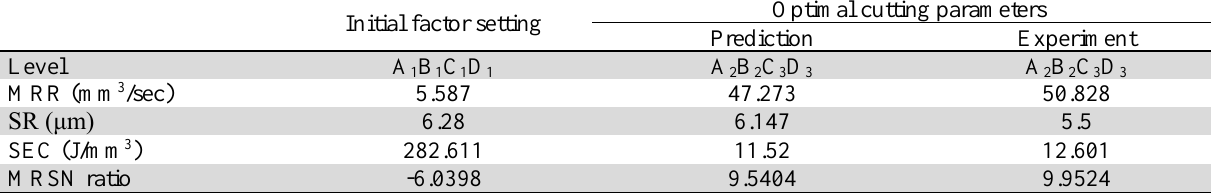
Results of the confirmatory experiment for MRSN ratio method Initial factor setting